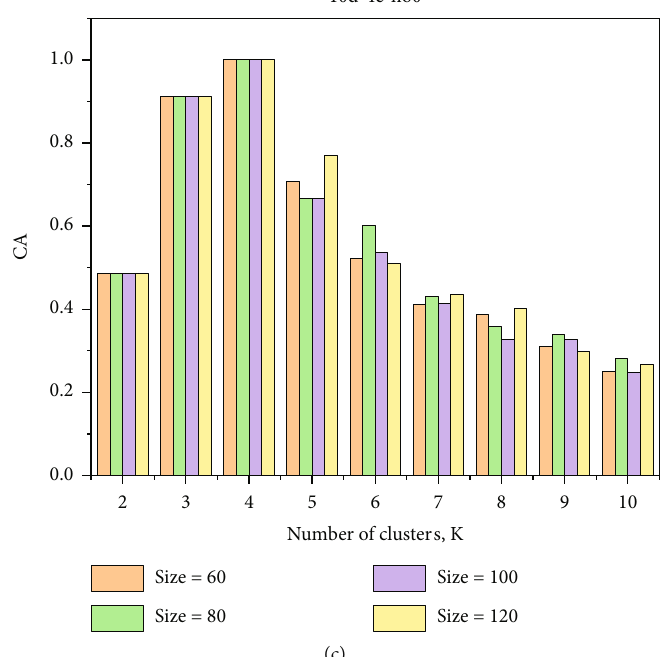
Figure 3: The accuracy of clustering results obtained by the proposed algorithm under di ff erent cluster numbers when setting di ff erent population sizes on datasets (a) 2d-20c, (b) spherical43, and (c)